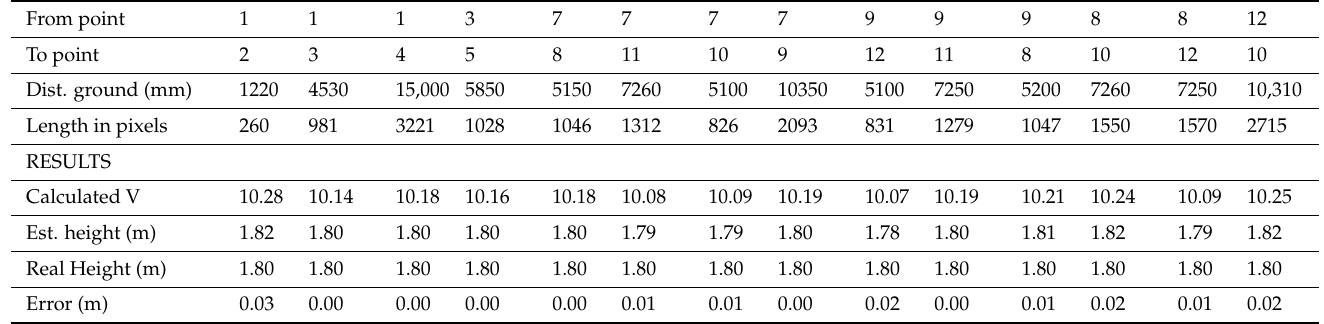
Table 4. Data collected during the Field Test 2 with results of the analysis considering image